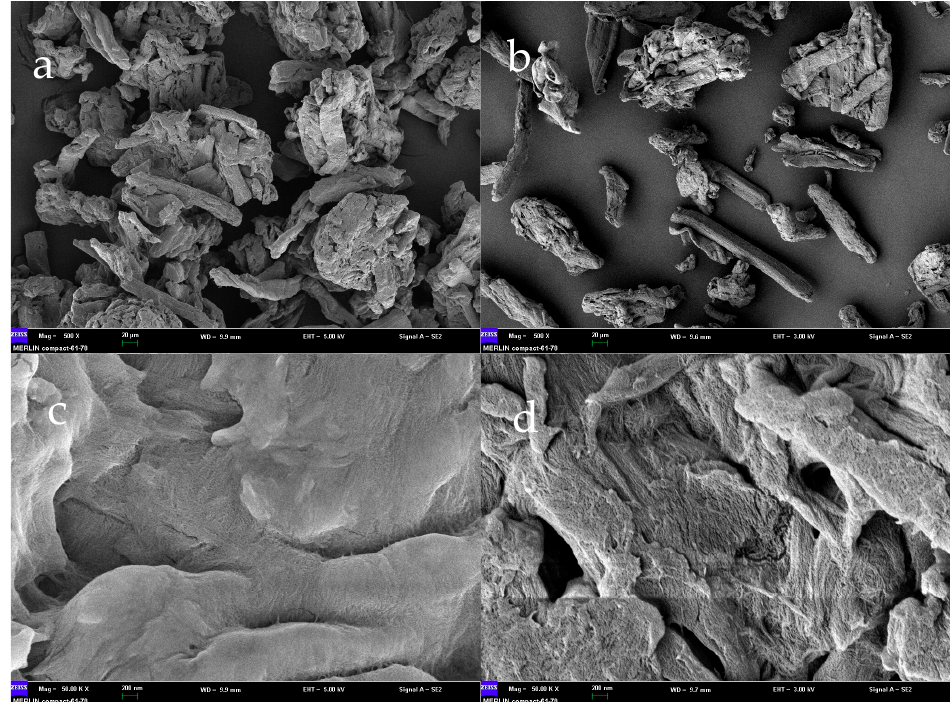
Figure 1. SEM of alkaline microcrystalline cellulose (( a ): 20 μ m and ( c ): 200 nm) and microcrystalline cellulose (( b ): 20 μ m and ( d ): 200 nm). SEM: scanning electron microscopy.